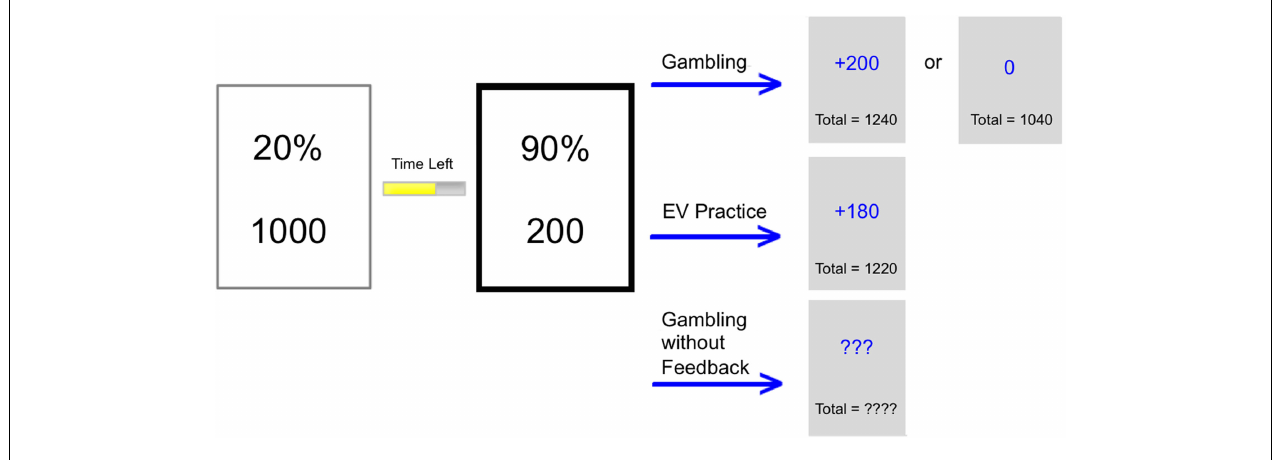
received no-feedback as to the outcome of their choices.The option on the right is highlighted to reflect that the participant has chosen that option and the consequences of that choice are shown to the right of each arrow.